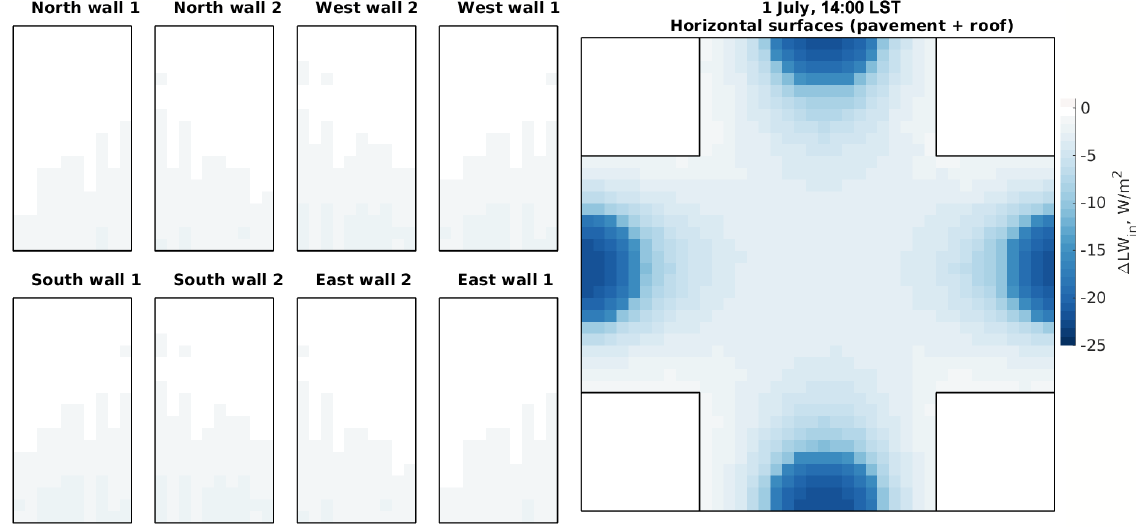
Figure 8. Changes in the received diffuse SW radiation flux within the focus domain of the simple urban configuration when considering vegetation interaction with SW solar radiation (RTM_03) compared to the RTM_02. Walls, roofs, and pavements are folded the same way as those in Fig. 6.